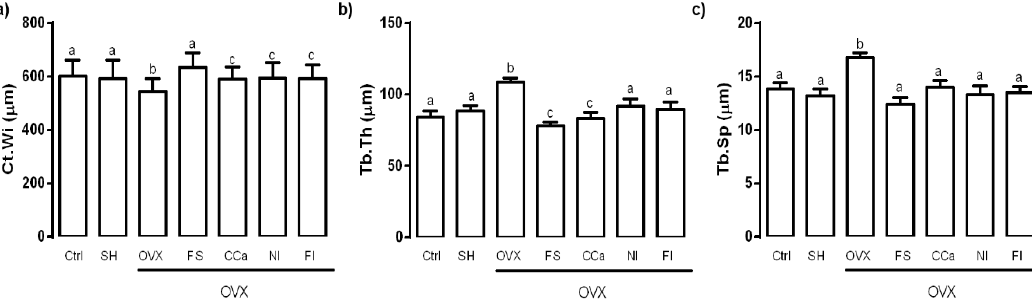
Figure 4. ( a ) Cortical thickness (Ct.Wi), ( b ) trabecular thickness (Tb.Th) and ( c ) trabecular separation (Tb.Sp) in femoral bone of experimental groups. The results represent the average ± SD of the experimental groups, n = 5 rats/group. Means in bars with different letters indicate significant differences ( p ≤ 0.05) between groups with Tukey’s test. Ctrl = control group, SH = sham group, OVX = ovariectomized group fed with AIN-93M, FS = ovariectomized group fed with diet supplemented with soluble fiber extracted from O. ficus-indica , CCa = ovariectomized group fed with diet supplemented with calcium citrate, NI = ovariectomized group fed with diet supplemented with O. ficus-indica powder, FI = ovariectomized group fed with diet supplemented with insoluble fiber extracted from O. ficus-indica .